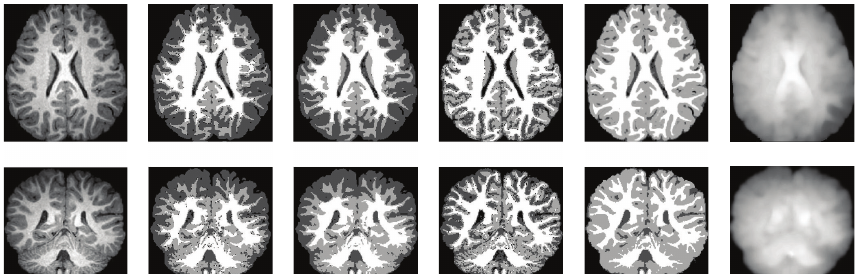
Figure 5: Comparison of segmentation results on two 3T brain MR images. Column 1: original images. Column 2: the BCFCM algorithm. Column 3: the sFCM algorithm. Column 4: the CLIC algorithm. Column 5: the proposed algorithm. Column 6: the estimated bias fields by the proposed